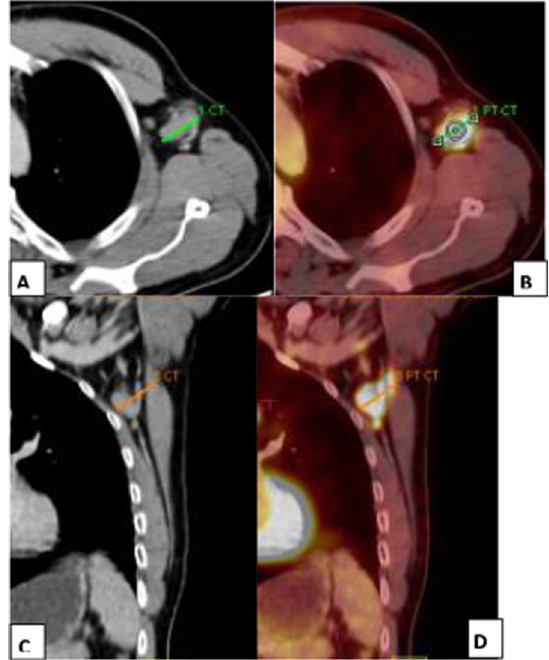
Fig. 6 A 39-year-old male patient with NHL, treated with anti-cd20 antibody rituximab 3 months prior to vaccination. FDG PET/CT performed 7 days after the 2nd dose of Pfizer-BioNTech COVID-19 vaccine. A Axial and C coronal CECT images at the axillary level revealed enlarged left axillary LNs about 3.5 cm B Axial and D coronal PET/CT images revealed FDG-avid left axillary LNs with 3.7